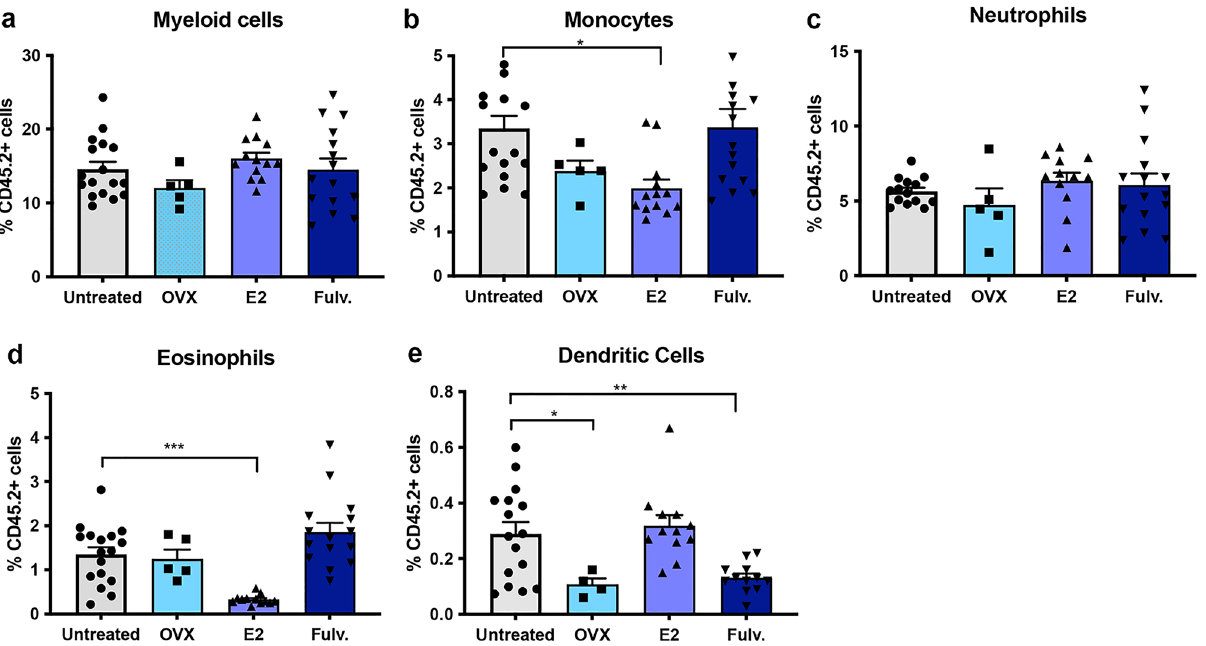
Figure 5. Effects of estrogen, oophorectomy and fulvestrant on the blood innate immune cells. Mice were either untreated, ovariectomised (OVX) or treated for 6 weeks with estrogen (E2) or Fulvestrant (ICI). ( a ) Myeloid cells, ( b ) monocytes, ( c ) neutrophils, ( d ) eosinophils, ( e ) dendritic cells. Results are expressed percentage of immune cells (mean ± SEM). n = 5–17 mice/group. Data was analysed using a Turkey multiple